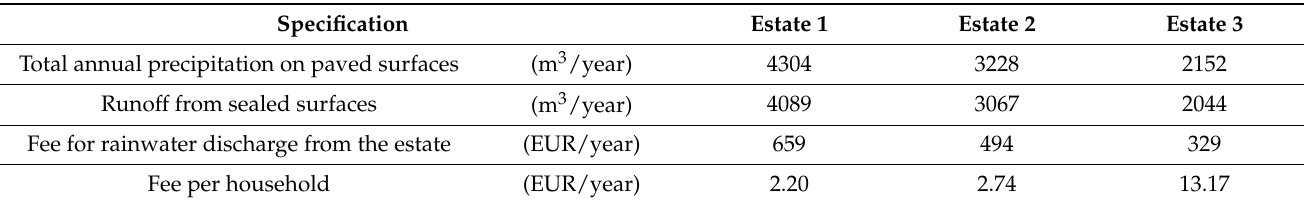
Table 9. National fees for rainwater discharge to the sewer